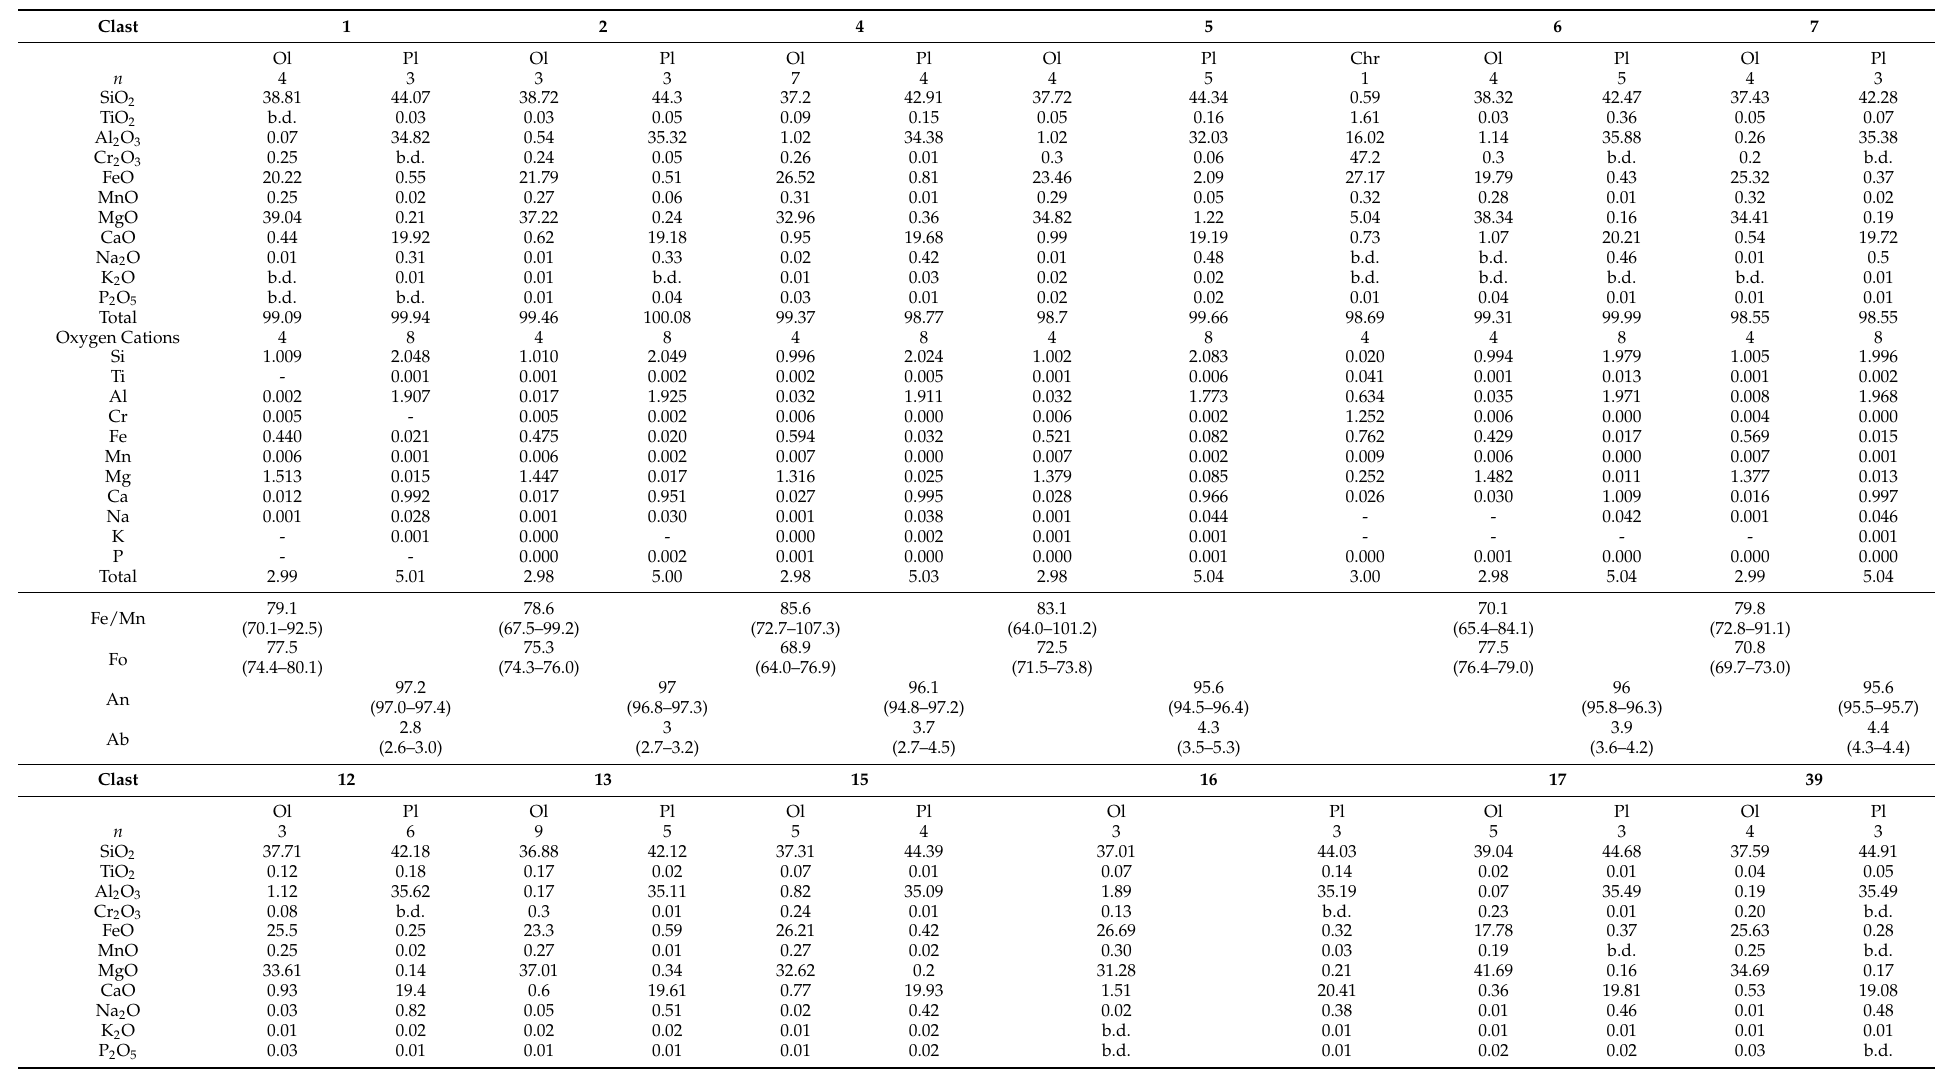
Table 1. Compositions of representative minerals in first type of crystalline impact melt